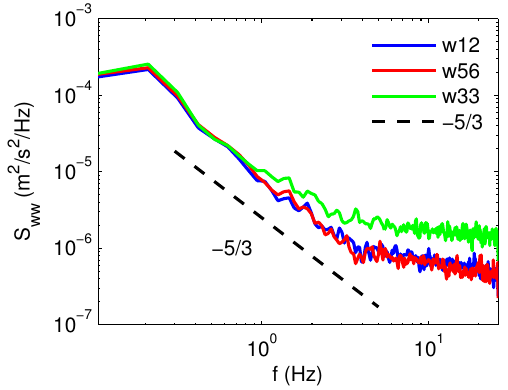
Figure 13. Vertical velocity spectra at 80 cm range – i.e. 3 cm above the bed – illustrating the well-resolved inertial subrange in the WBBL. Green indicates w from the centre transducer, red and blue w from the two orthogonal outboard pairs. YD130.64.